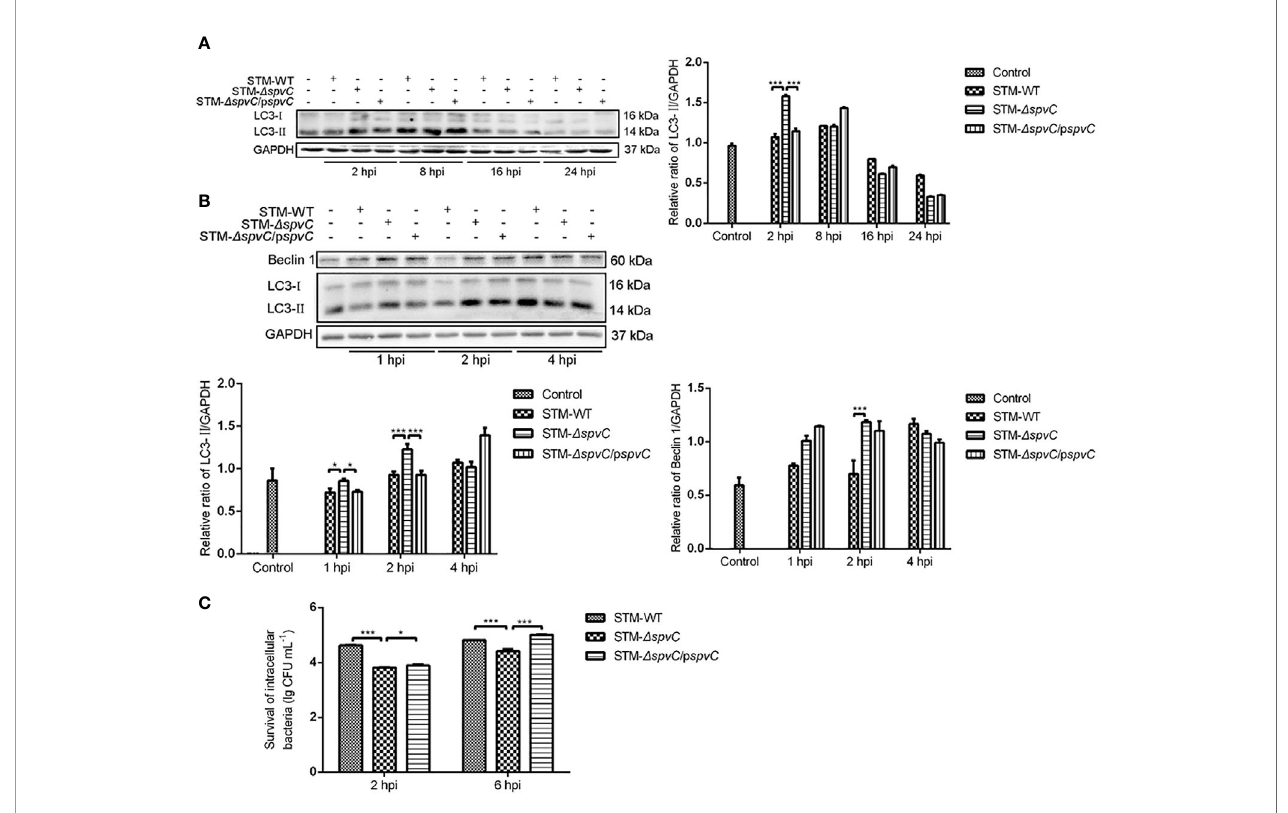
FIGURE 1 | SpvC suppresses autophagy and increases intracellular survival of Salmonella Typhimurium in macrophages at the early stage of infection. (A, B) J774A.1 cells were infected with STM-WT, STM- D spvC or STM- D spvC /p spvC at an MOI of 10. Cell lysates were analysed by western blot with speci fi c antibodies to LC3 and the control GAPDH at 2 hpi, 8 hpi, 16 hpi and 24 hpi (A) , to Beclin 1, LC3 and the control GAPDH at 1 hpi, 2 hpi and 4 hpi (B) . (C) Intracellular bacterial loads of J774A. 1 cells were assayed by colony forming units counting. Data were compared by ANOVA. Values are expressed as the means ± S.D., n = 3. Statistically signi fi cant differences are indicated. *** P < 0.001; * P <